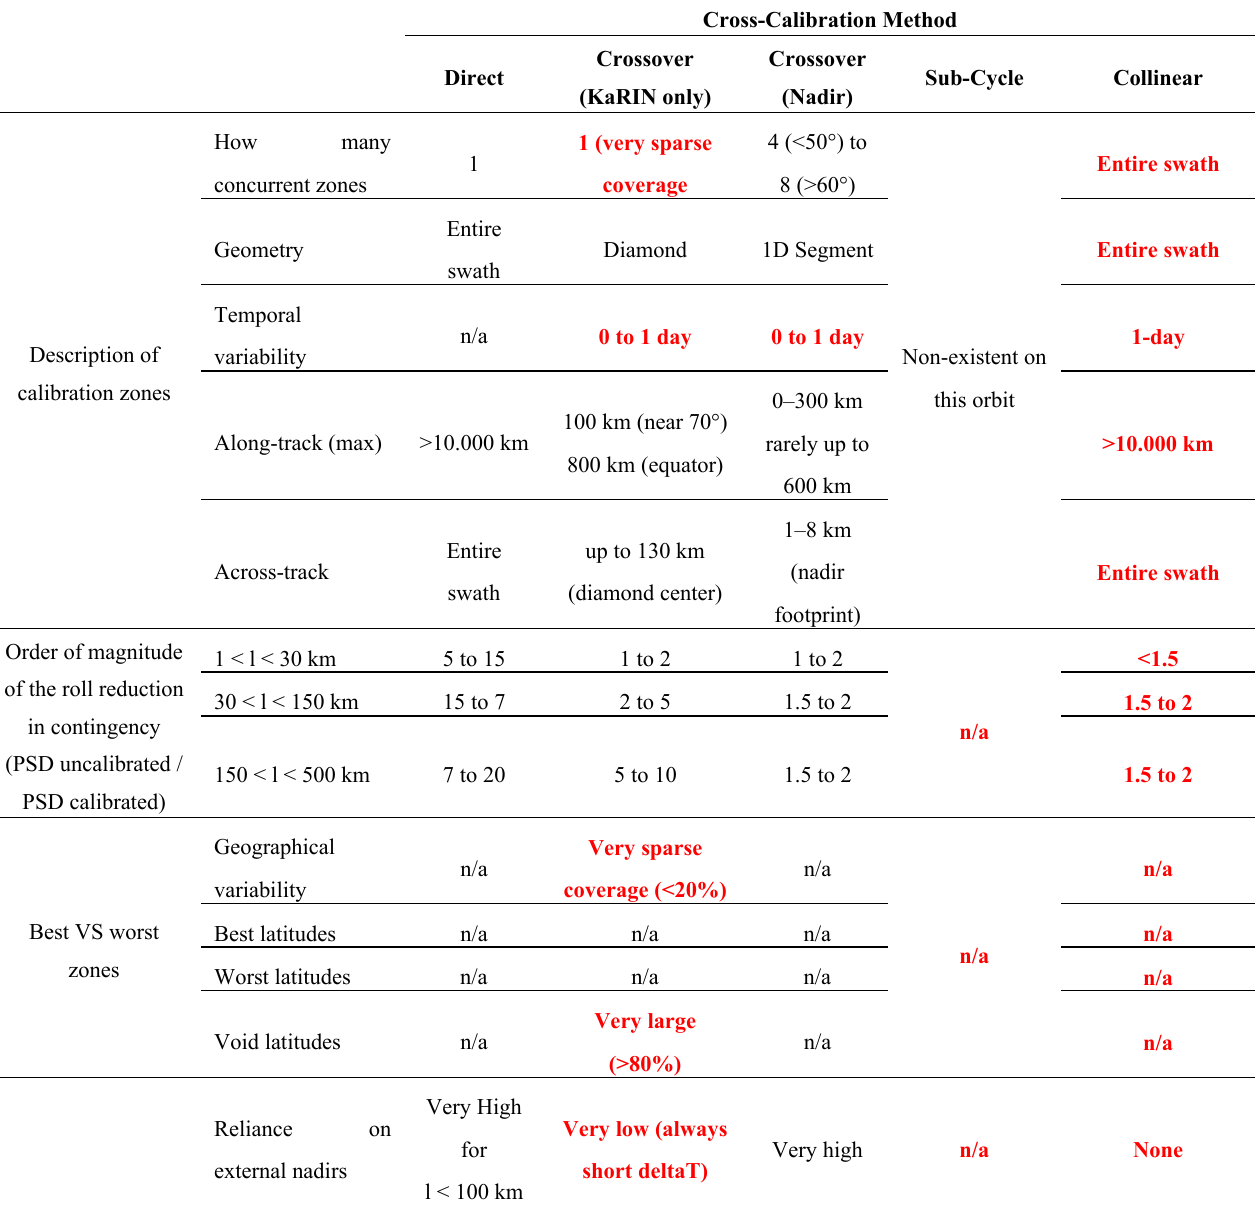
Table 3. Synthesis for commissioning/CalVal orbit (exact 1-day